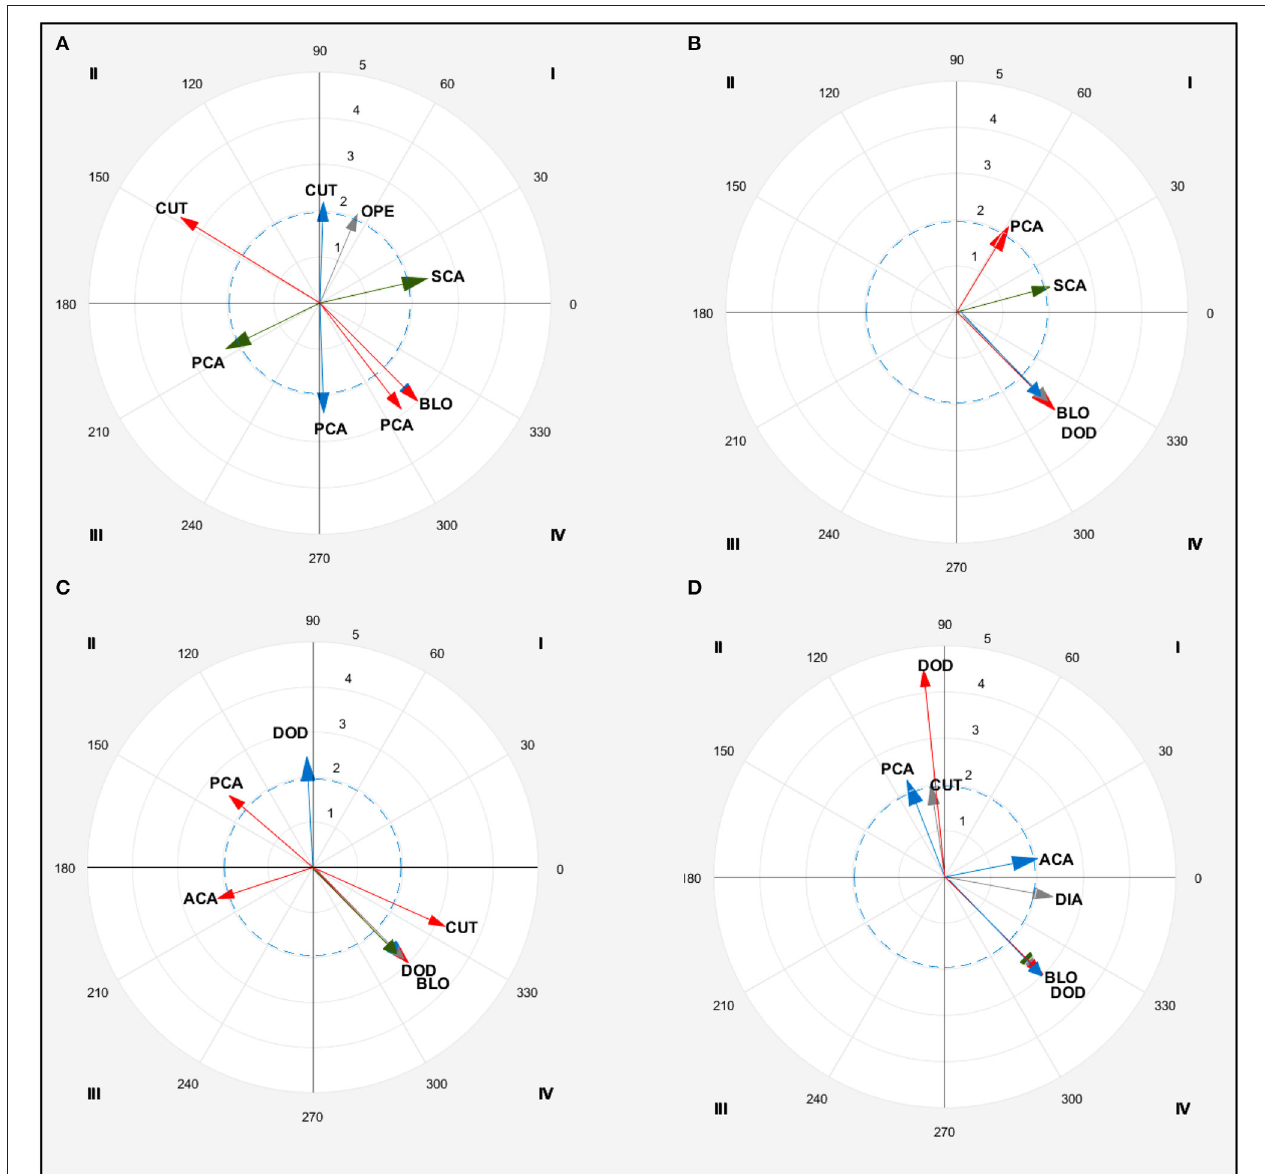
FIGURE 2 | Polar coordinate analysis of one-point (A) , two-point (B) , three-point (C) , and four-point (D) actions for males. Color arrows indicate significant relationships ( z > 1.96) in each weight category: fin (blue), feather (green), light (red), and gray (heavy). DIA, Direct Attack; INA, Indirect Attack; BLO, Blocks; DOD, Dodge; OPE, Opening; ACA, Anticipatory counterattack; SCA, Simultaneous counterattack; PCA, Posterior